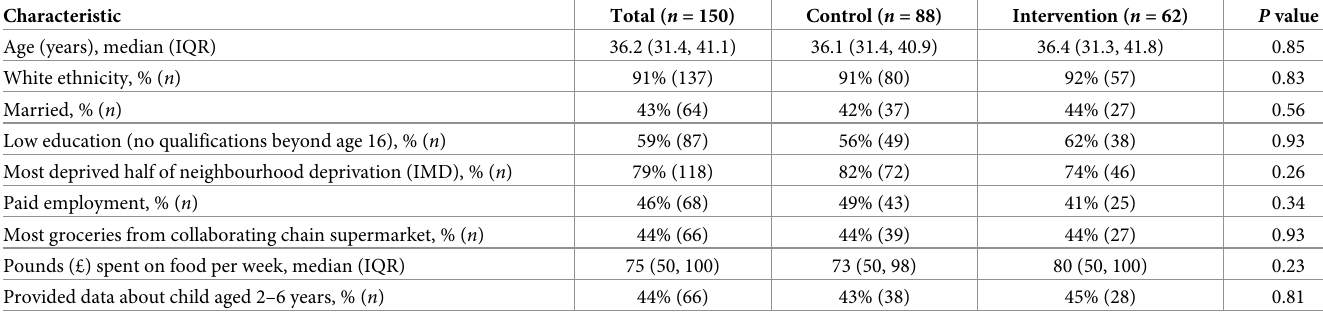
Table 1. Baseline characteristics of 150